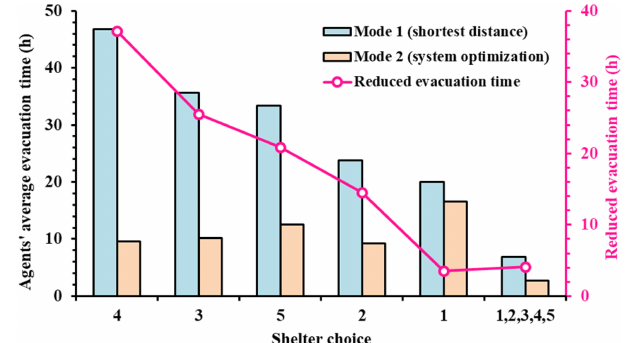
Figure 13. Comparison of the average evacuation time of agents for the two evacuation-route-searching strategies.